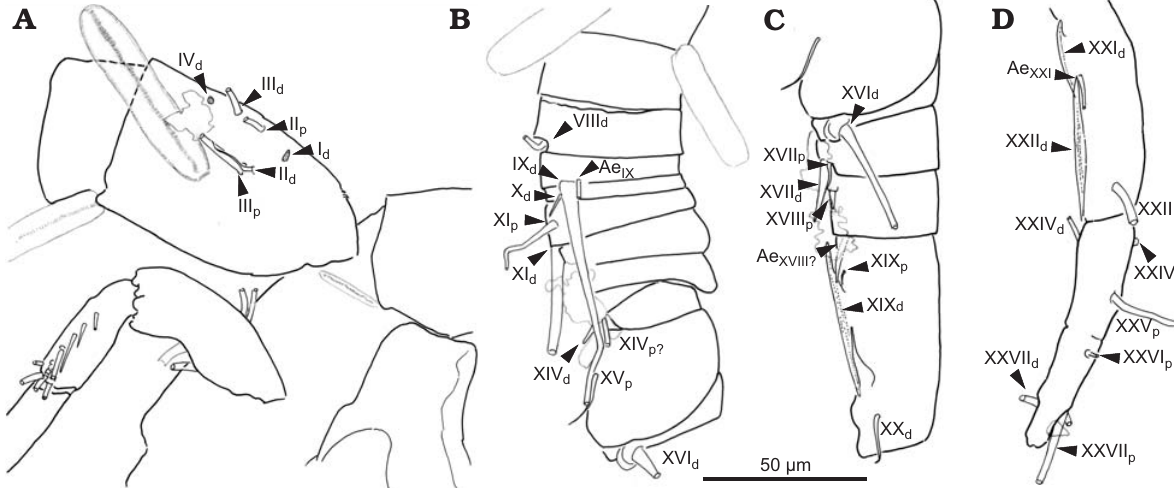
Fig. 5. Cyclopid copepod Apocyclops californicus sp. nov. (UMNH IP 4850) from Mud Hills, Southern California; Burdigalian–Langhian, Miocene, adult male antennule in ventral view. The line drawings based on the scanning electron micrographs (see Fig. 4) show some setal elements or their insertion sites (coding as in Fig. 1). A . Segments 1 − 2 (I − VII). B . Segments 2 − 11 (VI − XVI). C . Segments 11 − 14 (XVI − XX). D . Segments 15 − 16 (XXI −